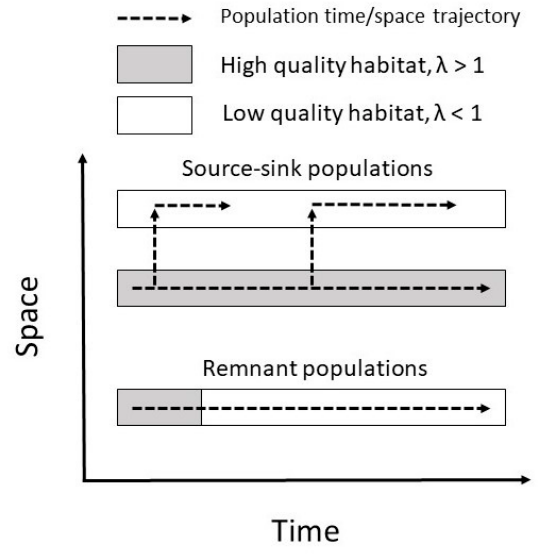
Figure 2. A graphic illustration of the difference between source-sink and remnant populations (“source-sink populations in time”). Adapted from Ref. [59].